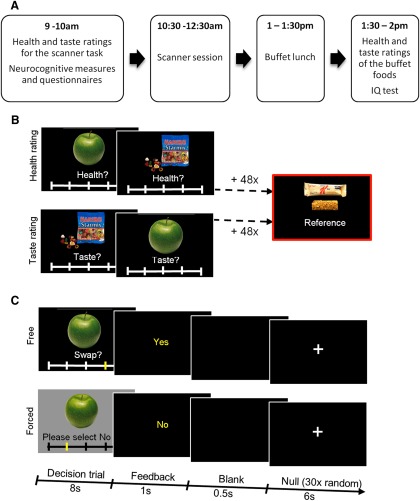
Study design and experimental task. A, Study design. B, Before the scanner session, participants rated 50 foods for their healthiness and tastiness, in two separate ratings blocks, the order of which was counterbalanced across participants. For each participant, the health- and taste-neutral food was selected as the reference food for the scanner task. C, The scanner food choice task featured the same 50 items presented as part of free and forced trials. Free and forced trials, of 8 s duration, were presented in a randomized order. After the decision trial was over, a 1 s feedback screen presented the decision that was made. This was followed by a 0.5 s blank screen. On 30 random occasions during the course of the task, a 6 s null trial with a fixation cross was presented after the blank screen.